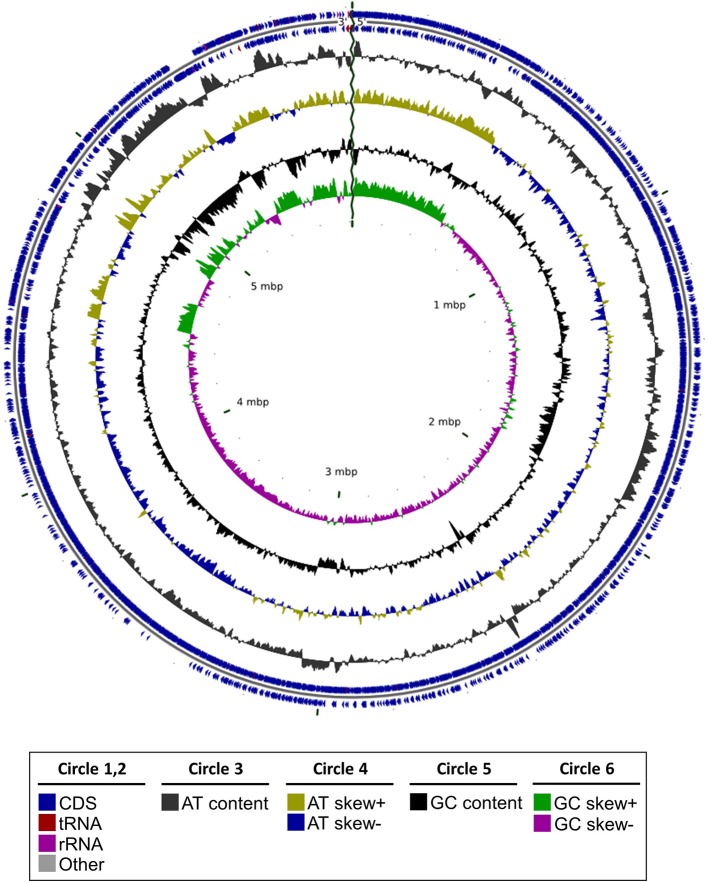
Graphical representation of the genome structure of Bacillus megaterium RmBm31. Circles from the outside to the inside show the positions of protein-coding genes (blue), tRNA genes (red) and rRNA genes (pink) and others (grey) on the positive (circle 1), and negative (circle 2) strands. Circles 3 and 4 show plots of AT content and AT skew plotted as the deviation from the average content of the entire sequence. Circles 5 and 6 show plots of GC content and GC skew plotted as the deviation from the average content of the entire sequence.